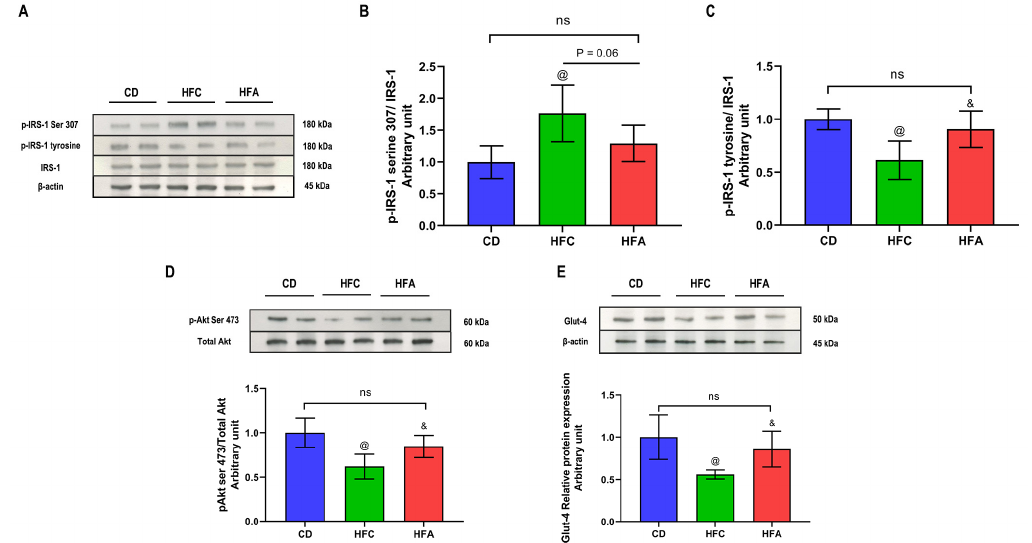
Figure 4. Effects of D -allulose supplementation for 4 weeks on adipokines and JNK signaling. ( A ) Levels of plasma TNF- α , ( B ) adiponectin, and ( C ) leptin. ( D ) Western blot showing bands of SAPK/JNK phosphorylation at Thr183/Tyr185 and total SAPK/JNK. ( E ) The level of SAPK/JNK phosphorylation at Thr183/Tyr185 vs. SAPK/JNK protein expression in the soleus muscle. Results are expressed as mean ± SD; n = 6 per group. @: CD vs. HFC, #: CD vs. HFA, &: HFC vs. HFA, p < 0.05; ns, no significant difference. The difference was determined by one-way ANOVA. CD: chow diet, HFA: HFD + D -allulose, HFC: HFD + cellulose, HFD: high-fat diet, JNK: Jun N-terminal kinase, SAPK: stress-activated protein kinase, and TNF: tumor necrosis factor.